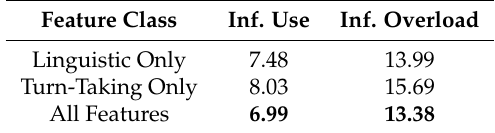
Table 3. MSE: Random Forests Models with Different Feature